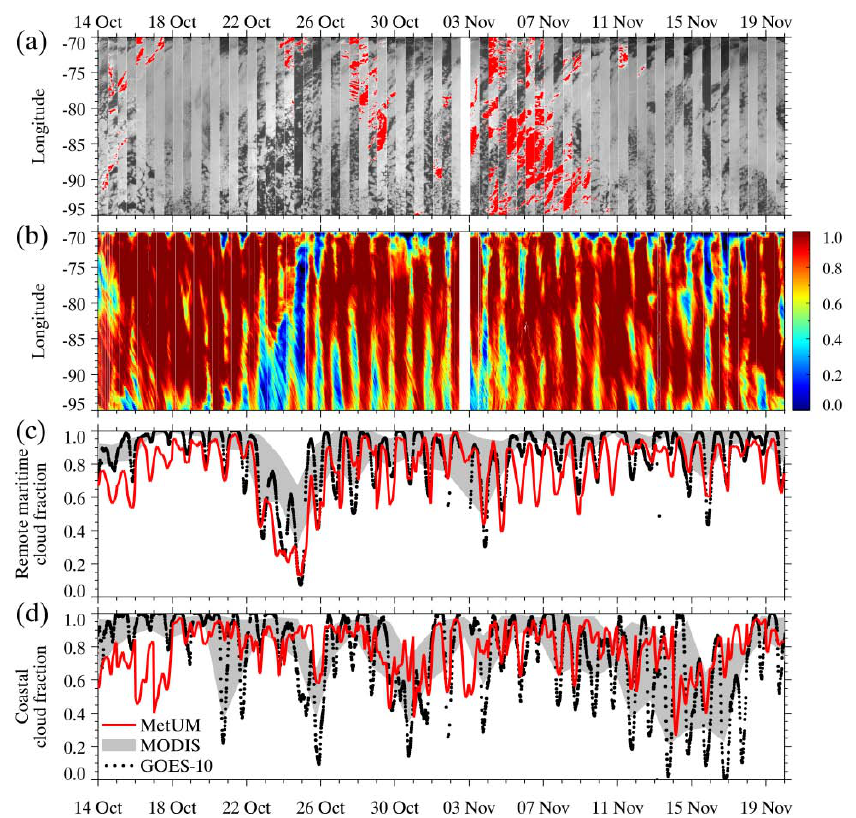
Fig. 5. Variability of low cloud cover along the 20 ◦ S latitude line from the 14 October to 19 November 2008. Panel (a) shows twice daily strips at ∼ 07:30 and 19:30UTC of the channel 4 BT from GOES-10. High cold clouds with a BT < 273 K are highlighted in red. Panel (b) shows a time-longitude plot of the GOES-10 low cloud fraction along 20 ◦ S derived from the channel 4 BT (data approximately every 30 min where available). Panels (c–d) compare the observed low cloud fraction from GOES-10 (black circles) and MODIS (grey band) with the MetUM forecast (red line) for the regions 80–90 ◦ W and 18–22 ◦ S in panel (c) and for 70–73 ◦ W and 18–22 ◦ S in panel (d)